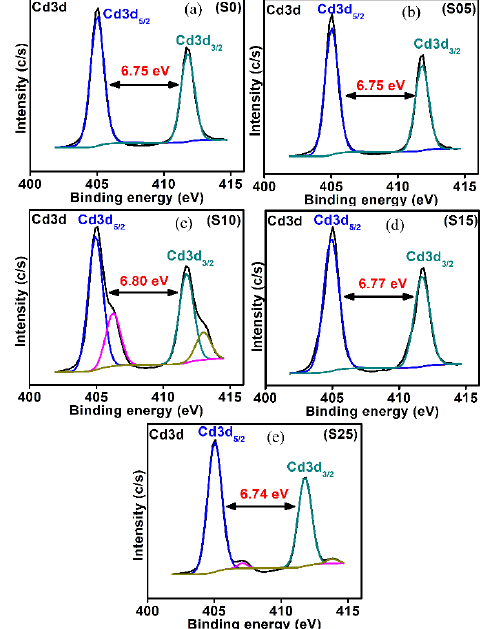
Figure 6. Chemical state analysis of Cd3d for the CdSe 1− x S x nanostructures with different content of sulfur. ( a ) x = 0.0 (S0 sample); ( b ) x = 0.05 (S05 sample); ( c ) x = 0.1 (S10 sample); ( d ) x = 0.15 (S15 sample); ( e ) x = 0.25 (S25 sample).